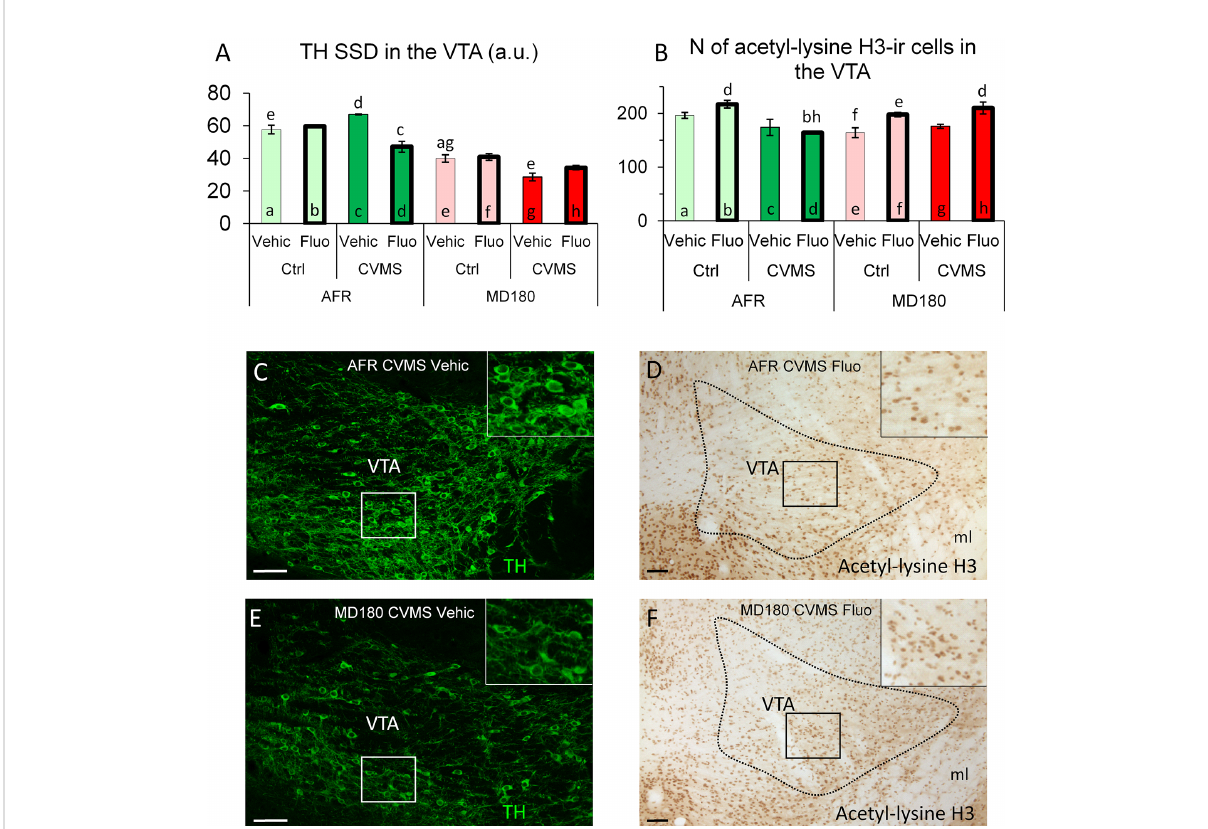
FIGURE 5 Summary of morphological results in the ventral tegmental area (VTA). (A) Speci fi c signal density (SSD) of tyrosine-hydroxylase (TH) in the VTA, expressed in arbitrary units (a. u.). (B) N of acetyl-lysine H3 histone-immunoreactive (ir) cells in the VTA. Microphotographs of TH (green) immuno fl uorescence in the VTA of an animal facility-reared (AFR), chronic variable mild stress-exposed (CVMS), physiological saline-injected (Vehic) mouse (C) and a maternally deprived (MD180), CVMS, Vehic animal (E) . (D, F) Microphotographs of acetyl-lysine H3 histone-ir cells in the VTA of an (D) AFR, CVMS, Fluo and an (F) MD180, CVMS, Fluo animal. Lettering at the top of bars represents the most relevant signi fi cant statistical differences between pairs of groups according to the post hoc tests (p<0.05). Ctrl: control (i.e. not exposed to CVMS); ml: medial lemniscus. Bar = 100